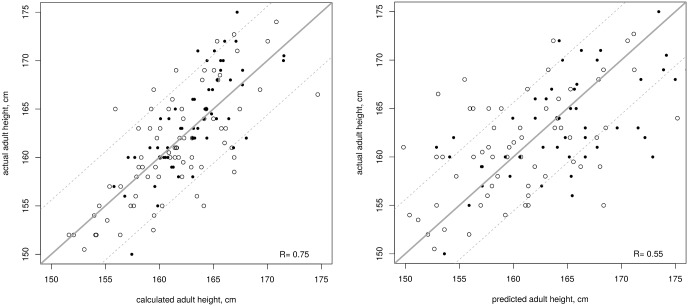
Correlation between actual adult height and calculated adult height (left) or adult height predicted by the Bayley Pinneau method [25] (right) in 78 treated (empty circles) and 56 untreated girls (plain circles) with idiopathic CPP using the formula from http://www.kamick.org/lemaire/med/girls-cpp15.html.Plain line represents the reference perfect prediction (calculated = actual), and dotted lines represent ± 1 SD from that value.